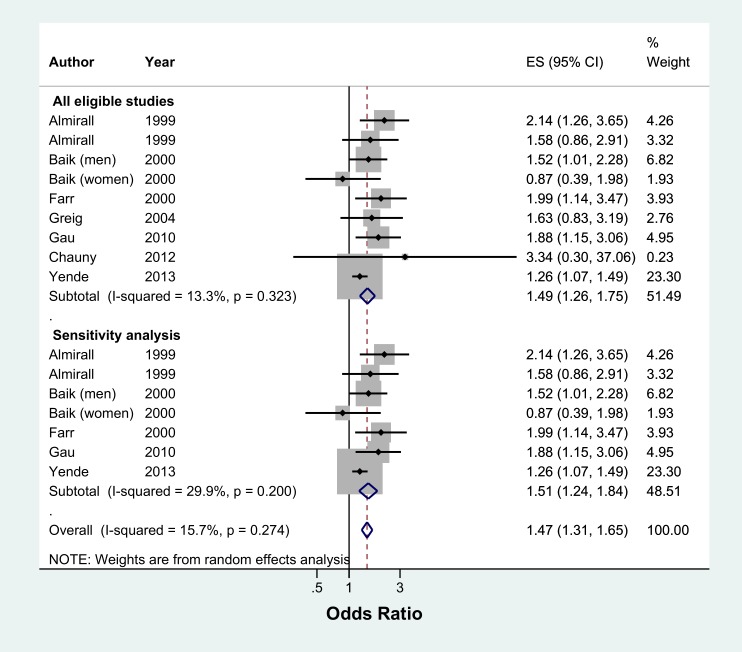
Meta-analysis of risk of community acquired pneumonia in ex-smokers relative to never smokers (Odds Ratio).Grey box = effect estimates from single studies. Diamond = pooled result with confidence interval. Vertical line at ‘1’ on the x-axis is the line of no effect. Weight (in %) = influence an individual study had on the pooled result.